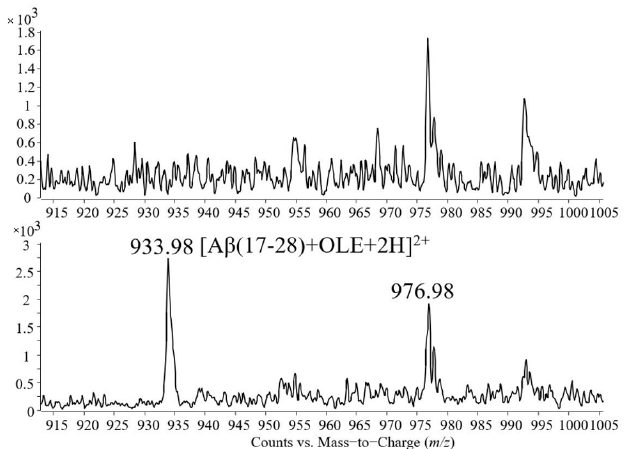
Figure 6. Detailed view of the m / z range 915–1005 and comparison between the sample containing A β (1–40) tryptic mixture presented in Figure 4 and the sample containing A β (17–28)-oleuropein noncovalent complex presented in Figure